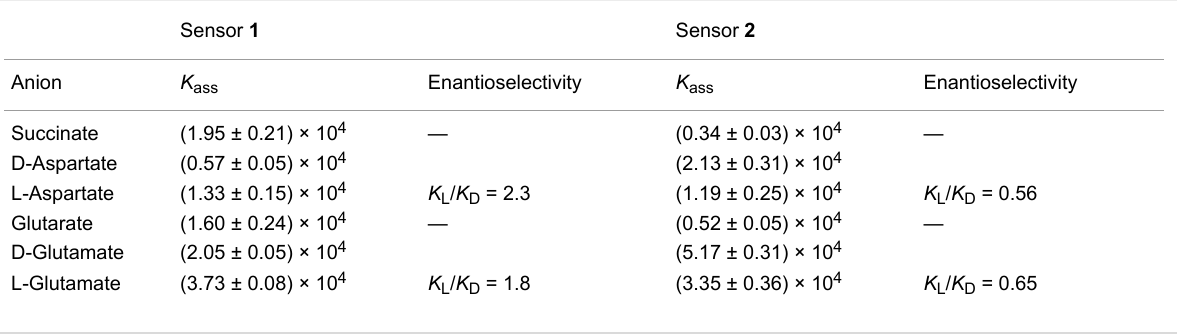
Table 2: Association constants K ass (M − 1 ) of sensor 1 and 2 with antipodal aspartate and glutamate (as their tetrabutylammonium salts) in CH 3 CN. Sensor 1